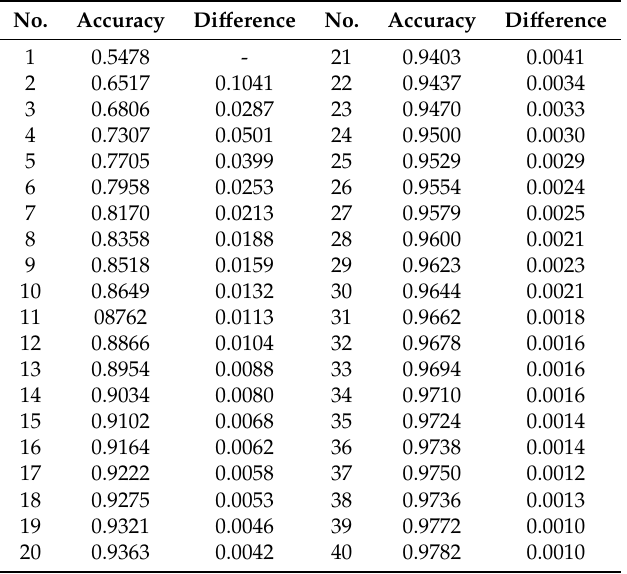
Table 14. Accuracy change and average di ff erence for each